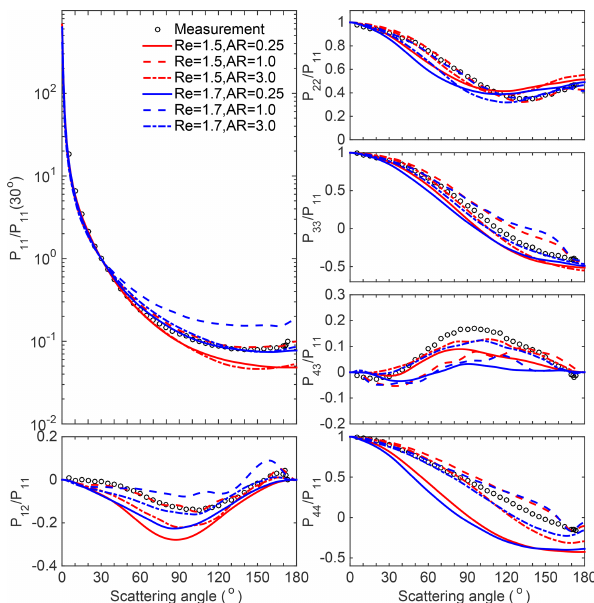
Figure 8. Comparison of the scattering matrix elements between the simulations and measurements for quartz samples with three differ- ent particle ARs at two different RIs: 1 . 5 + 10 − 3 i and 1 . 7 + 10 − 3 i . The incident wavelength is